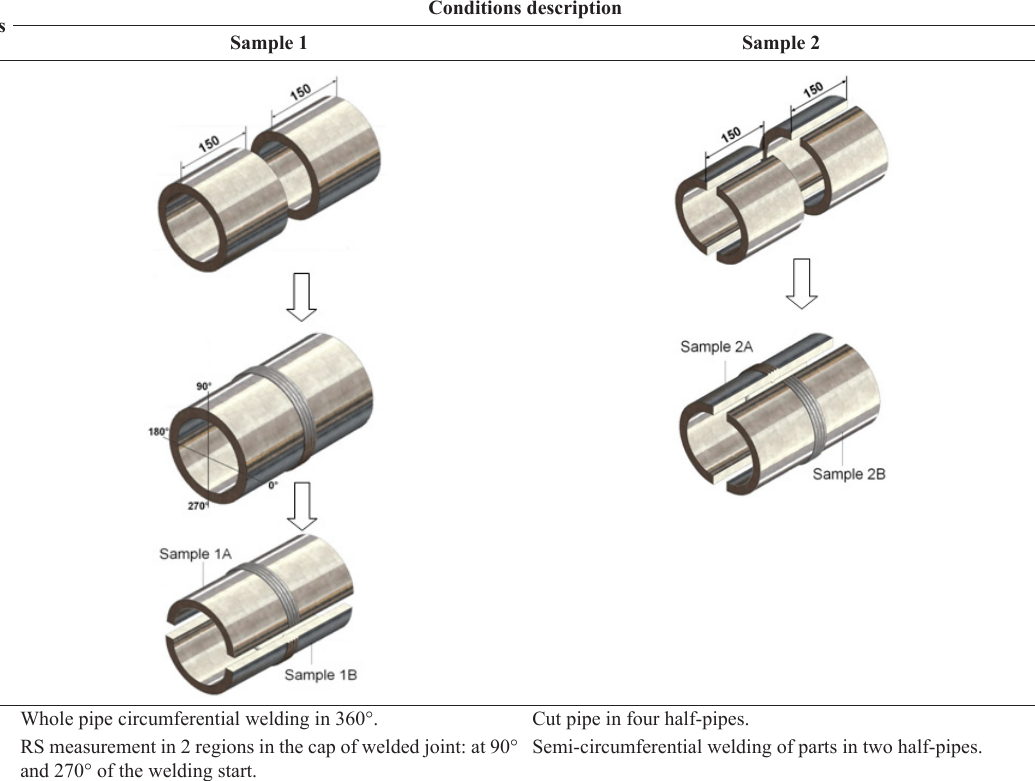
Table 5. Conditions description of the experimental steps.